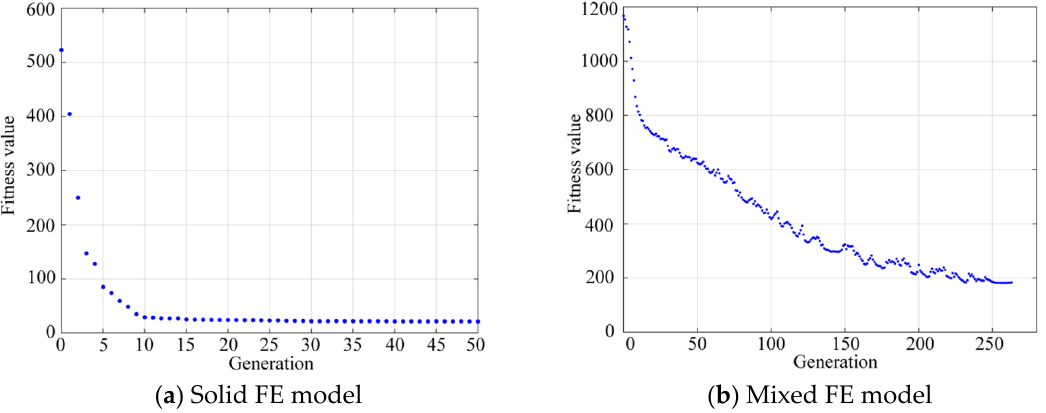
Figure 9. The change curve of objective function value with the number of iterations.